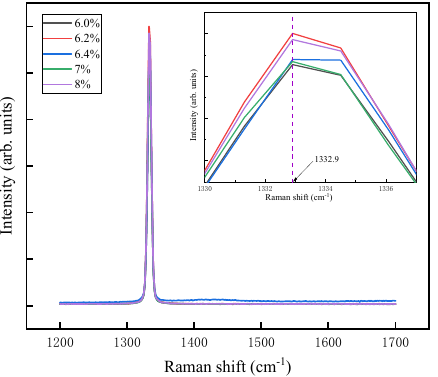
Figure 4. Raman spectra of substrates grown on different concentrations of CH 4 .